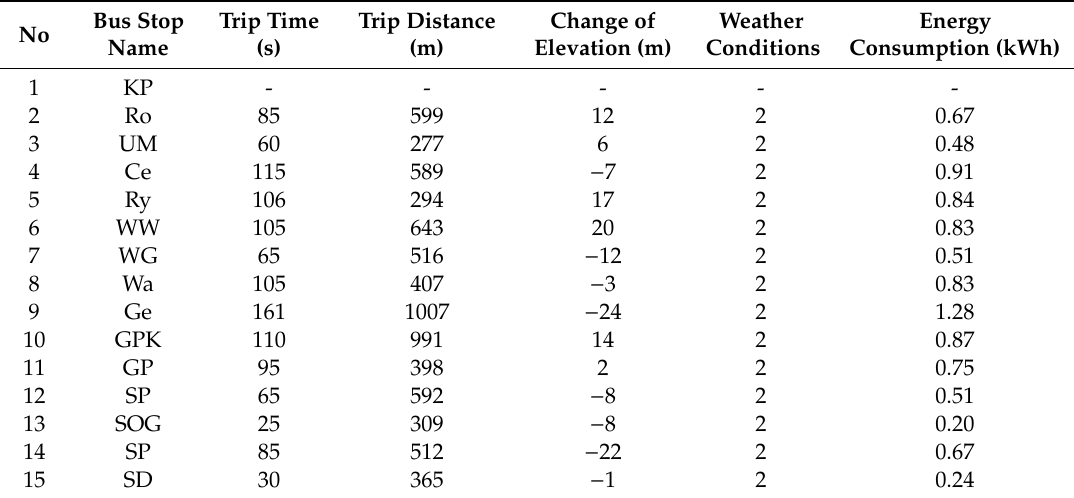
Table 3. Values of the deep learning network (DLN)